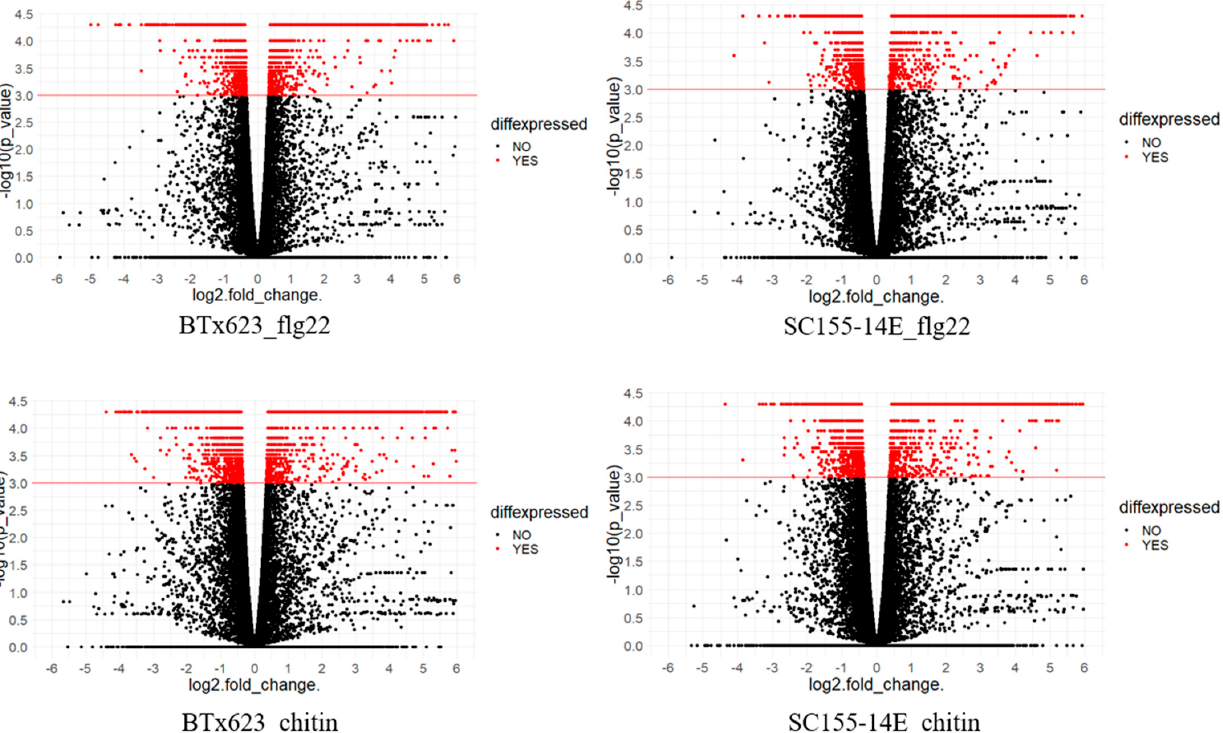
Figure 3. Volcano plots showing differential expression of genes in BTx623_treated with flg22 or chitin and SC155-14E treated with flig22 or chitin. The x -axis shows log2fold-changes in expression and y -axis shows statistical significance ( − log10 of the p -value). The red color dots represent DEGs and the black color dots represent the non-DEGs as marked in figure. Down-regulated transcripts are plotted on the left, up-regulated transcripts on the right.